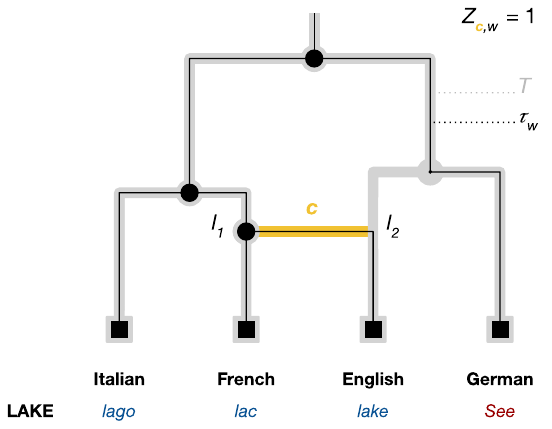
Fig. 1 Illustration of a word tree τ w (black) within the a language tree T (grey). As indicated by Z c , w = 1, the word is borrowed at the contact edge c , causing the word tree to deviate from the language tree. For example, the Middle English word lake was borrowed from Norman French lac , leading to matching form — meaning traits (indicated by blue/red colouring) in English and